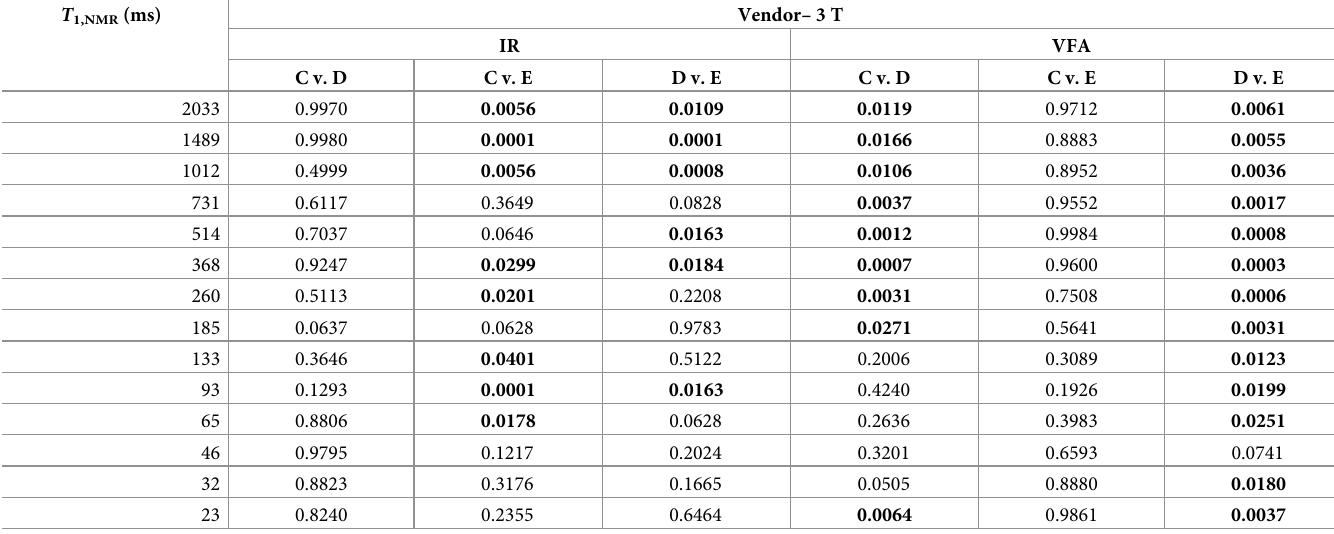
Table 5. ANOVA comparison for IR, VFA at 3 T.